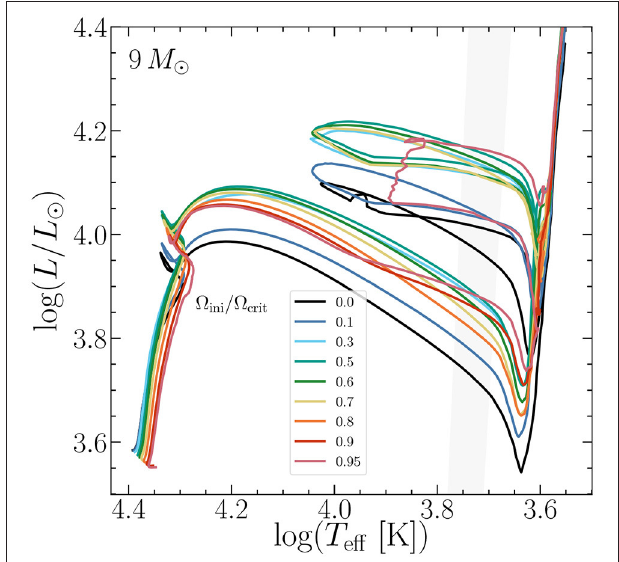
FIGURE 5 | Hertzsprung-Russell diagram for 9 M rotation (models from Georgy et al., 2013b).